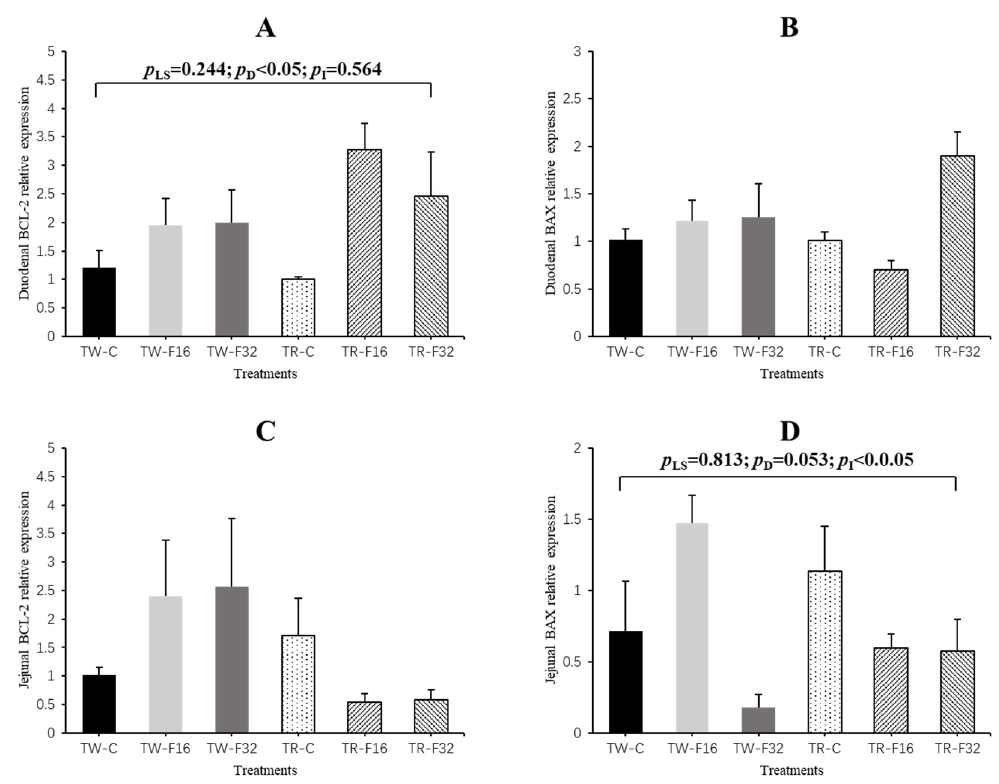
Figure 4. The duodenal gene expression of BCL-2 ( A ), BAX ( B ) and jejunal gene expression of BCL-2 ( C ) and BAX ( D ) affected by maternal folic acid supplementation. TW-CON, TW-F16 and TW-F32, twins born from ewes fed 0, 16 or 32 mg·(kg DM) − 1 folic acid in the control diet, respectively; TR-CON, TR-F16 and TR-F32, triplets born from ewes fed 0, 16 or 32 mg·(kg DM) − 1 folic acid in the control diet, respectively. p LS , p -value of litter size; p D , p -value of diet folic acid supplementation; p I , p - value of interaction effects between litter size and folic acid supplementation.